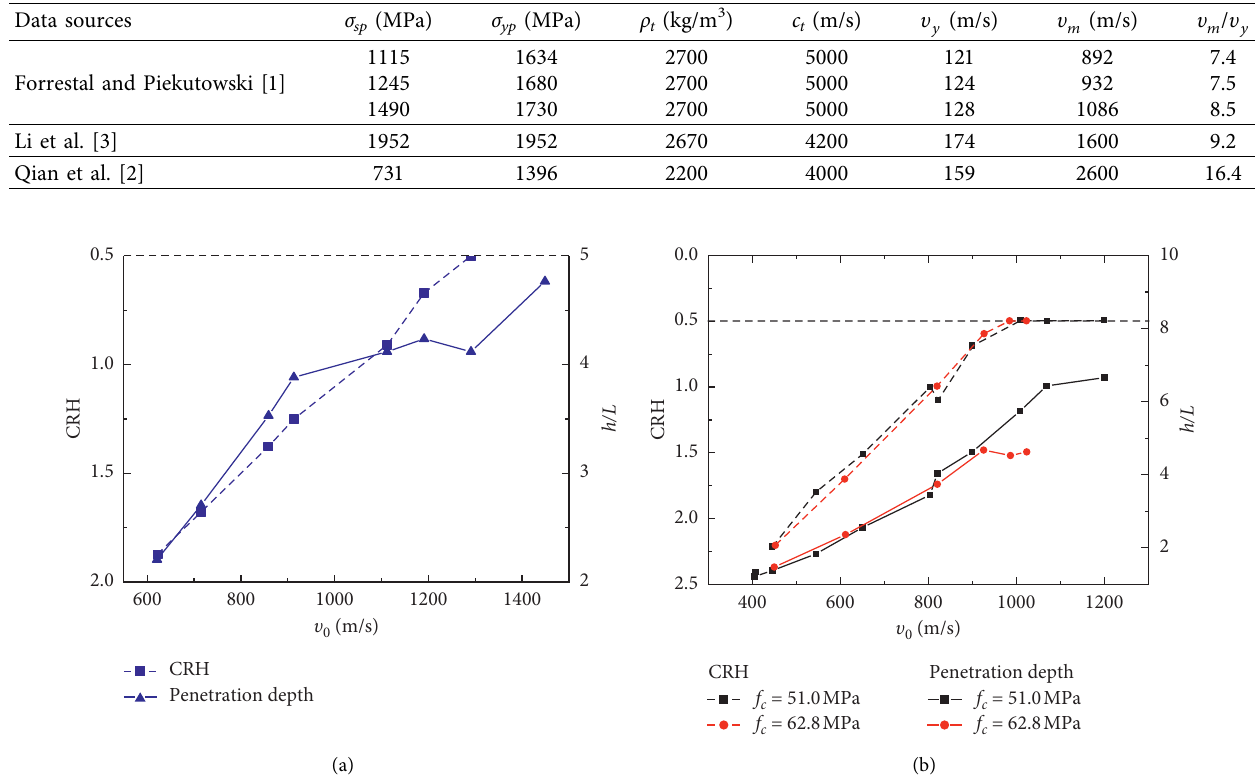
Figure 3: Curves of CRH and DOP vs. impact velocity. (a) Data from reference [18]. (b) Data from reference [10].